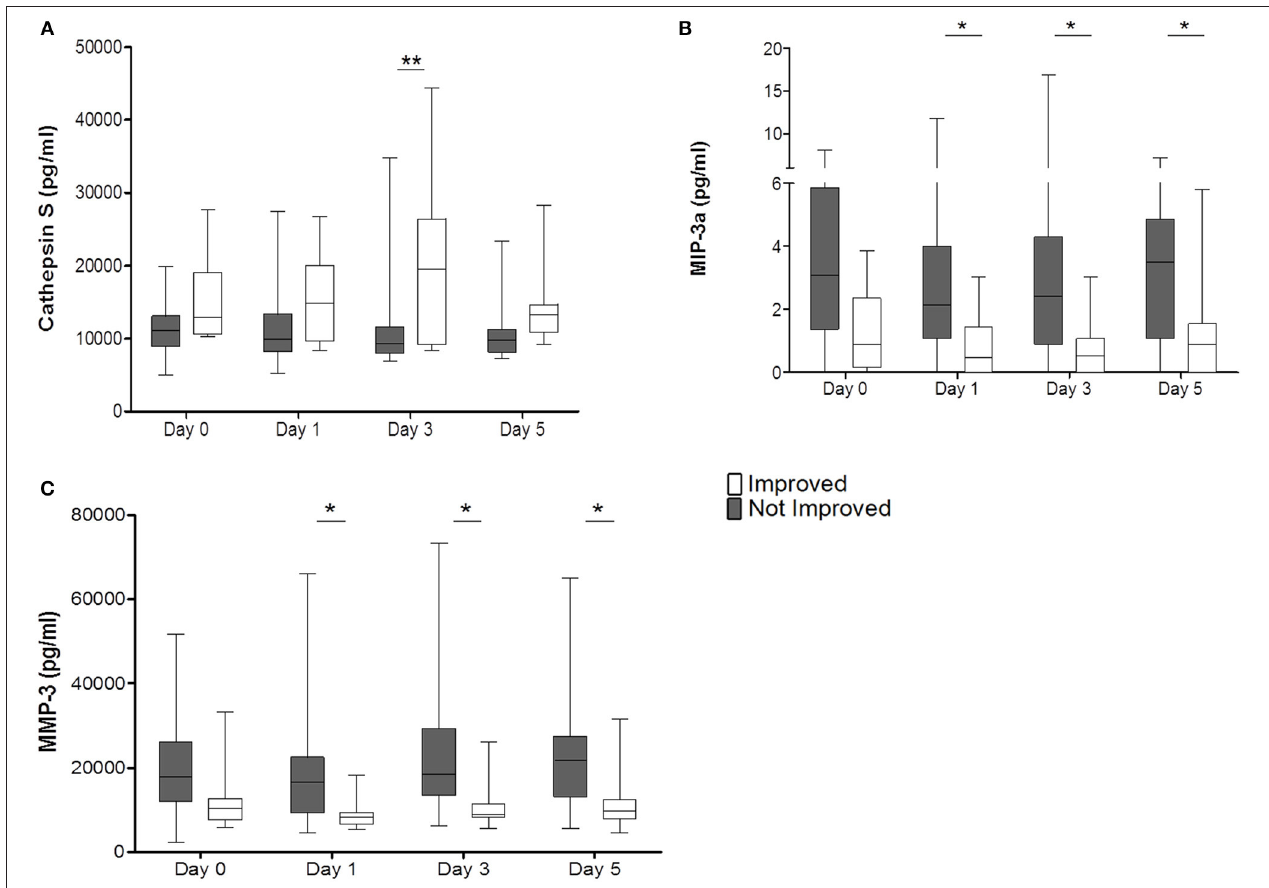
FIGURE 4 | Improved patients (white bars) and non-improved patients (gray bars) are given for Cathepsin S (pg/ml) (A) , MIP-3a (pg/ml) (B) , and MMP-3 (pg/ml) (C) . * p < 0.05; ** p < 0.01; Box and whiskers (Min–Max) are given (n imp = 13, n non − imp =